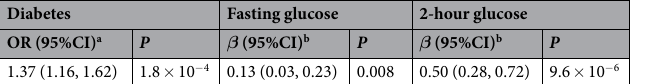
Diabetes Fasting glucose 2-hour glucose OR (95%CI) a P